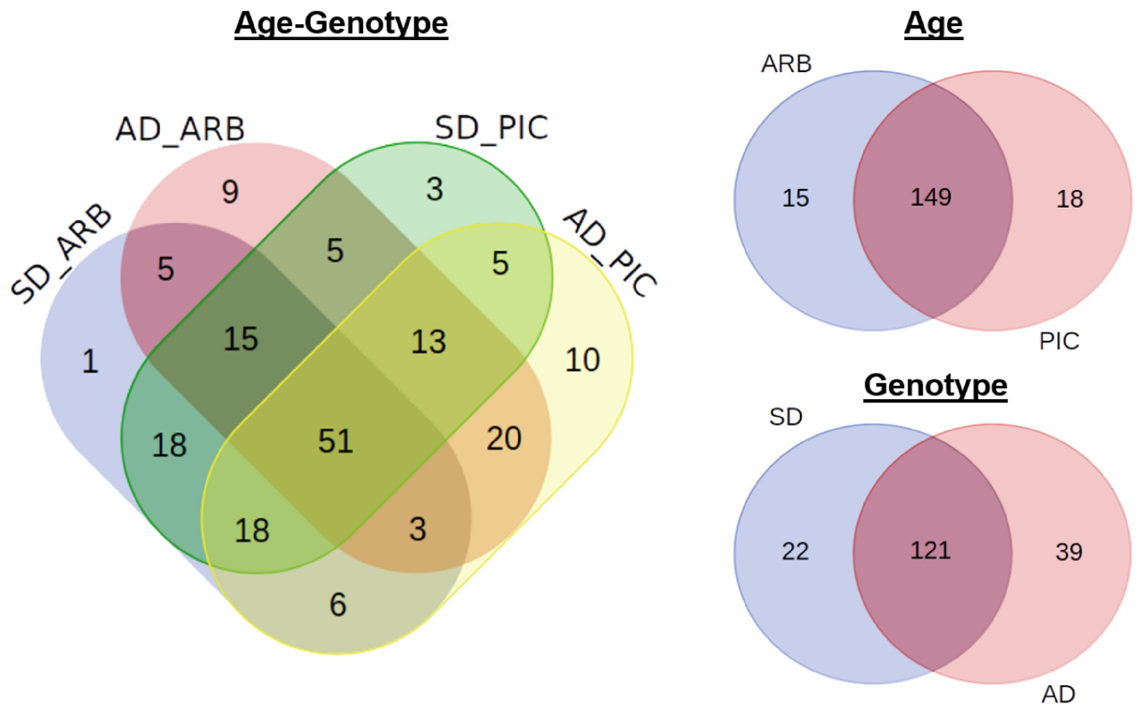
Figure 3. Prevalence Venn diagrams showing the unique and shared bacterial genera in olive xylem sap of plantlets (SD) and adult (AD) olive trees of ‘Picual’ (PIC) and ‘Arbequina’ (ARB) genotypes.